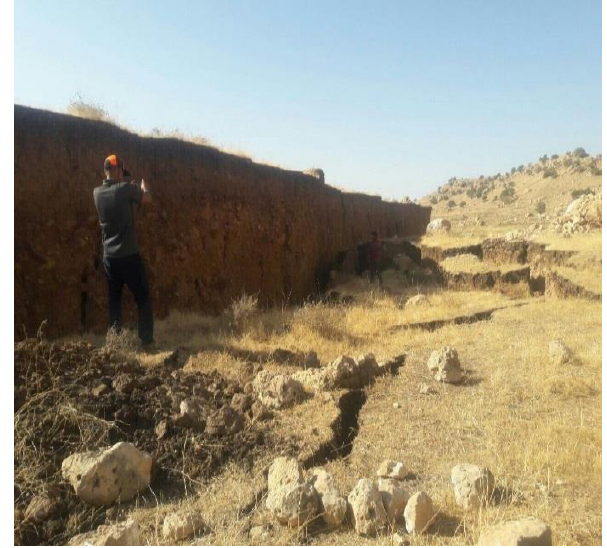
Fig. 1. An example of fault made in Kermanshah earthquake